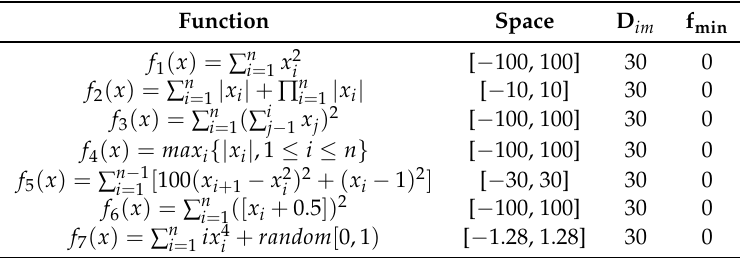
Table 1. Unimodal benchmark functions.